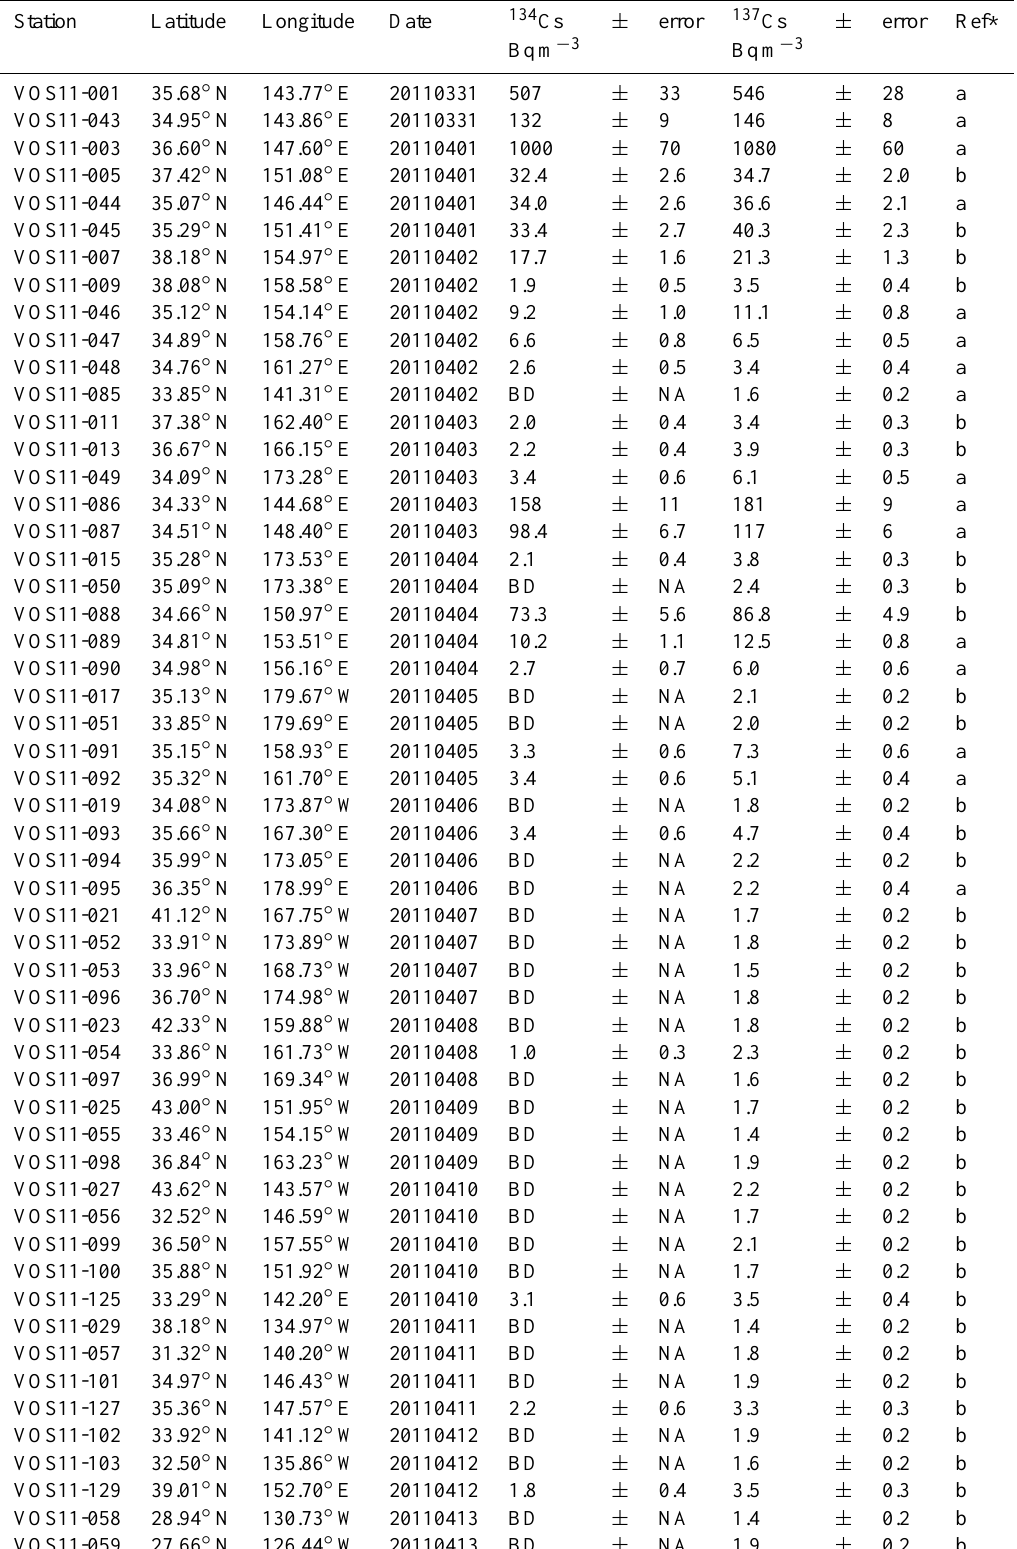
Table 1. 134 Cs and 137 Cs activity in the surface water in the North Pacific Ocean until March 2012.